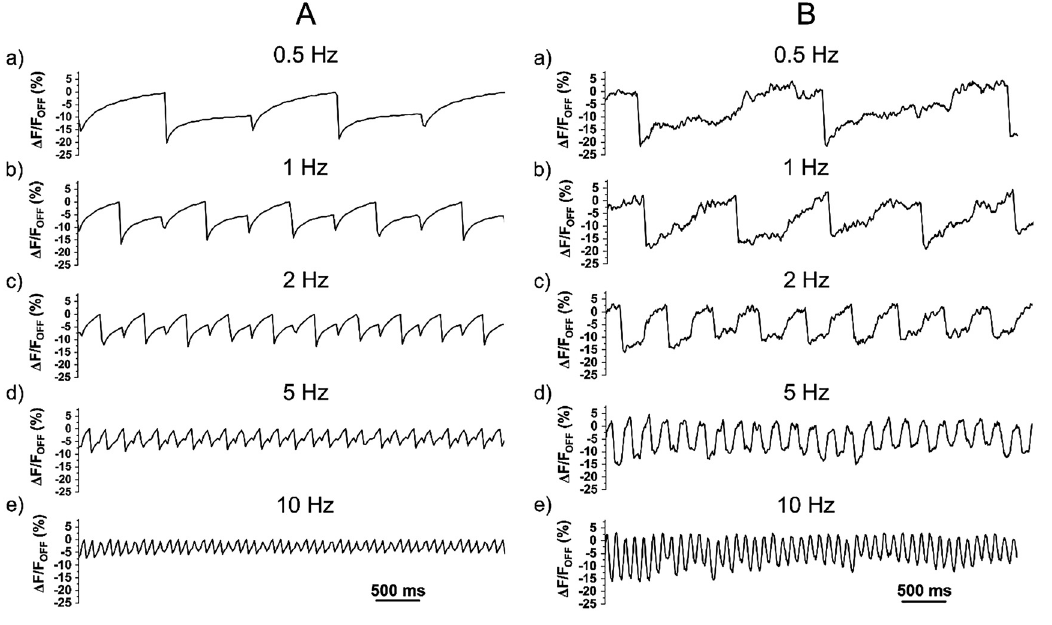
Figure 6: Effect of a frequency modulated E-field with an amplitude of 150 kV/cm on the fl uorescence changes of QR35-PSMA under (A) 1P excitation (460 – 495 nm) and (B) 2P excitation (900 nm).